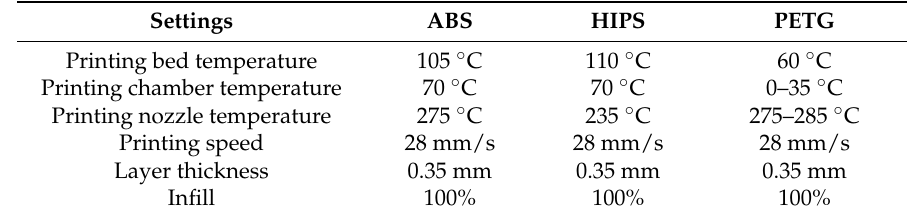
Table 1. 3D printing settings of each material.